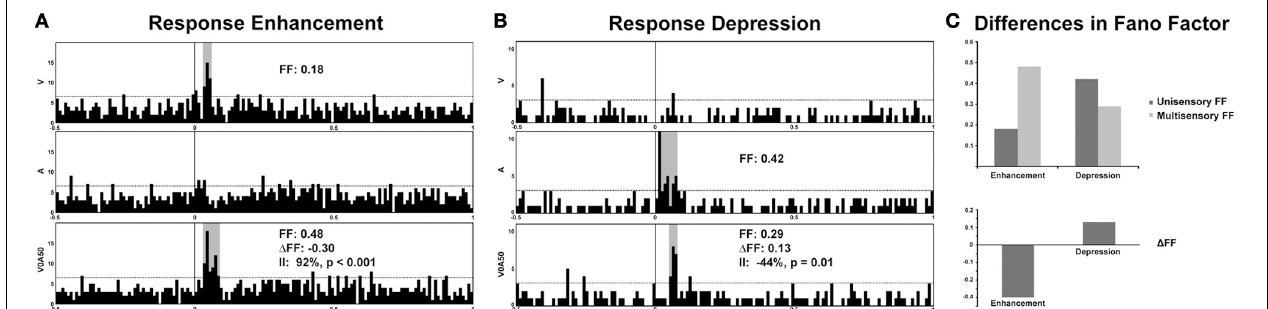
FIGURE 2 | Response variability in representative multisensory neurons from electrophysiological recordings in the superior colliculus of an awake cat. Note the significant enhancement of response under multisensory conditions (visual-auditory) compared to the best unisensory condition (92% enhancement of firing rate denoted by the Interactive Index, II; (A) Preliminary evidence from